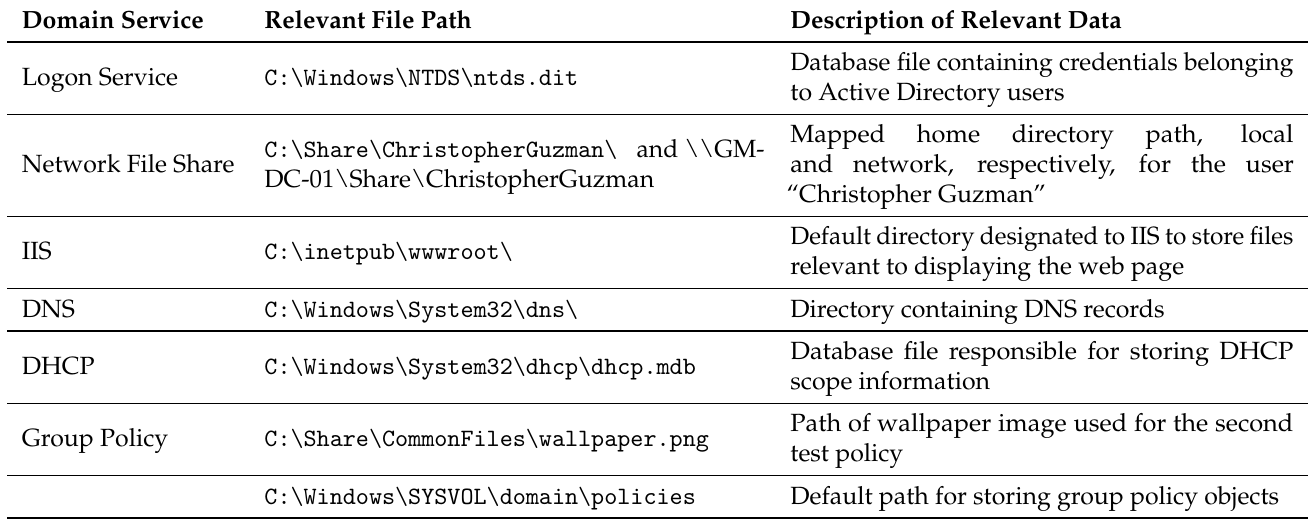
Table 3. Domain controller files and directories relevant to the investigation